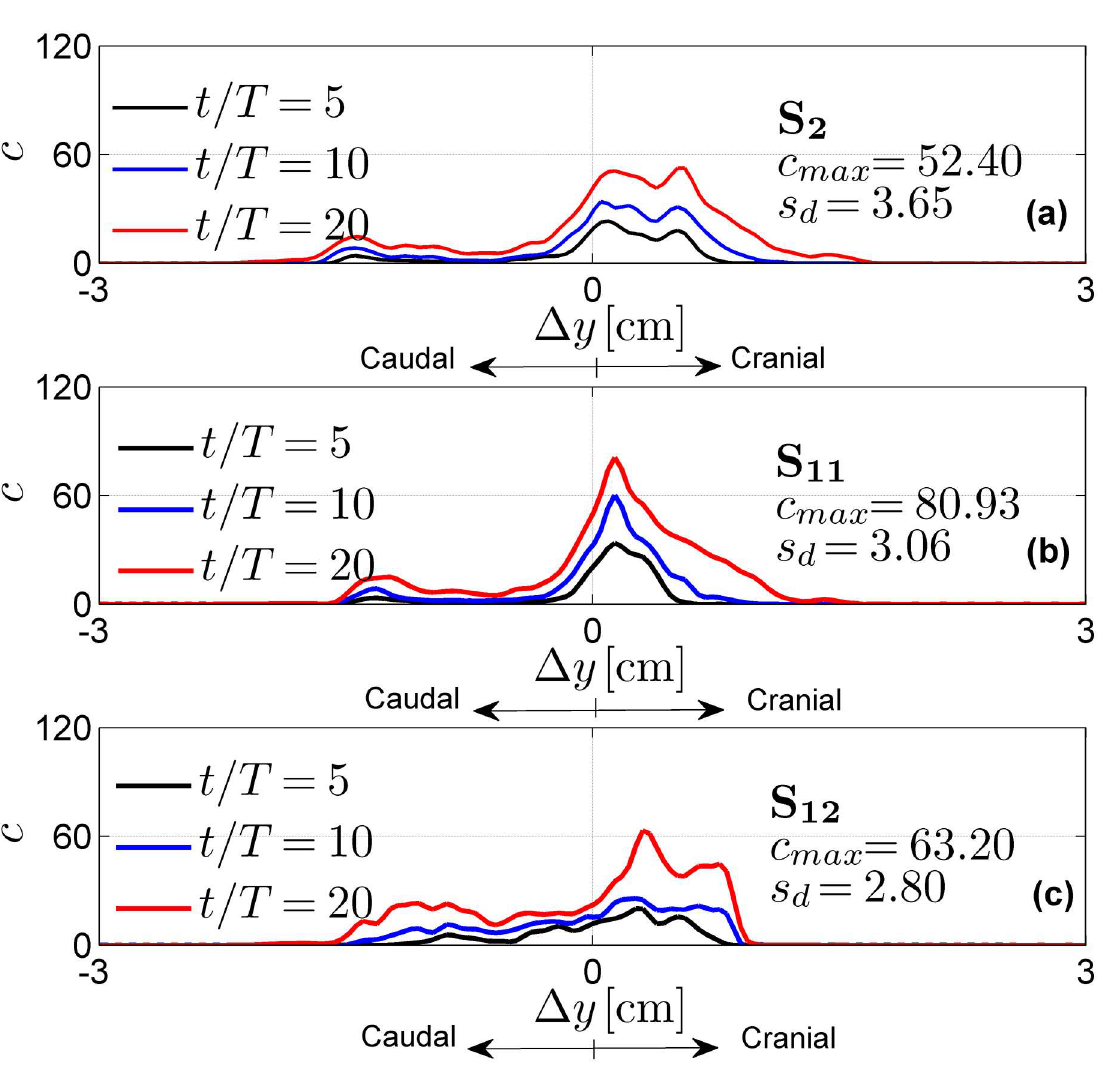
Fig 7. Normalized drug concentration profiles as a function of the distance Δ y from the injection point P 2 for different injection speeds. The profilesare obtainedwith test cases S 2 , S 11 , S 12 .